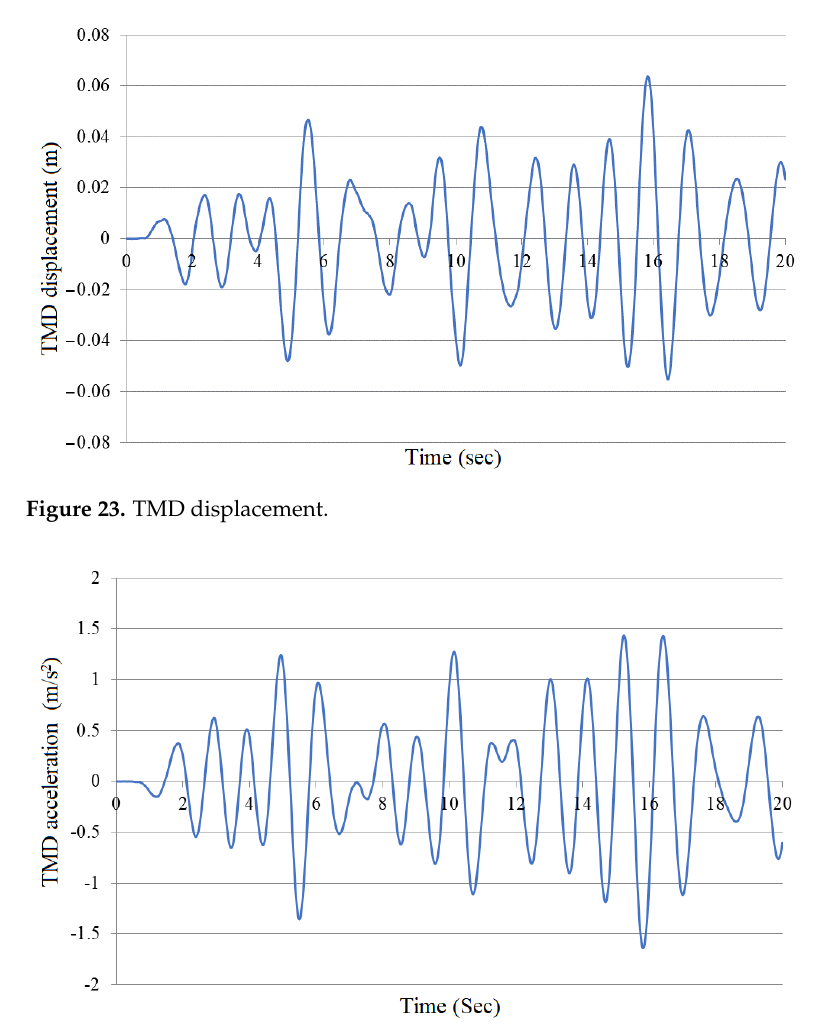
Figure 24. TMD acceleration.